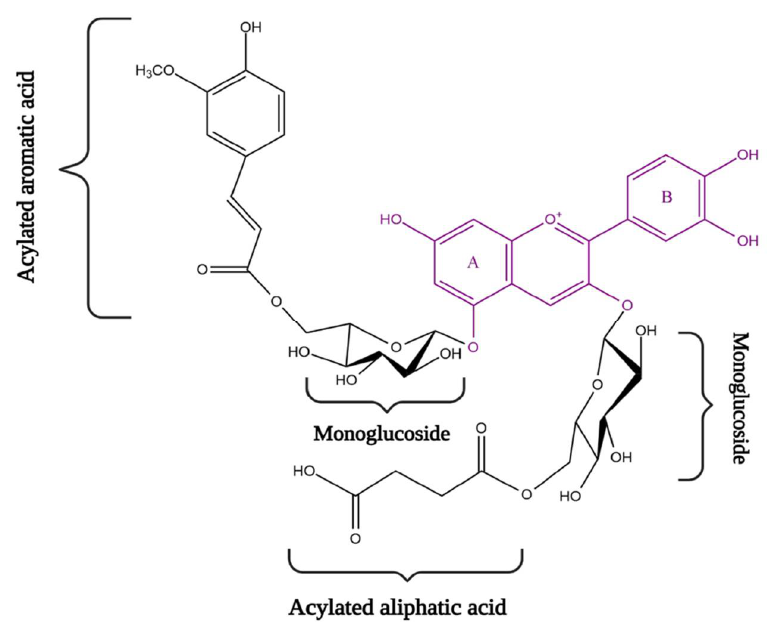
Figure 2. General chemical structure of anthocyanidin (flavylium cation) with sugar moieties and aromatic or aliphatic acid.